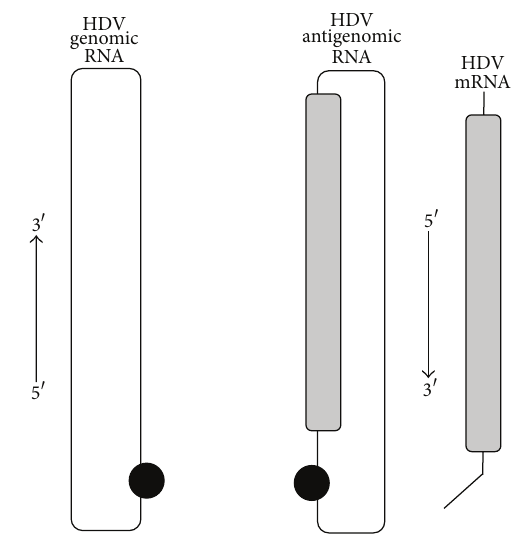
Figure 1: Schematic representation of three HDV RNA species. The HDV genomic RNA is a single-stranded circular RNA with ∼ 1700 nucleotides. It forms an unbranched rod-like structure due to intramolecular base pairing. The HDV antigenomic RNA is the exact complement of the genomic RNA, and both RNAs have site-specific ribozymes indicated by the black circle. The HDV antigenomic RNA contains the open reading frame for the delta antigen, represented in grey, but the antigen is translated from another RNA species, the mRNA. The mRNA is ∼ 800 nucleotides long with a 5 󸀠 -cap and a 3 󸀠 -polyadenylated